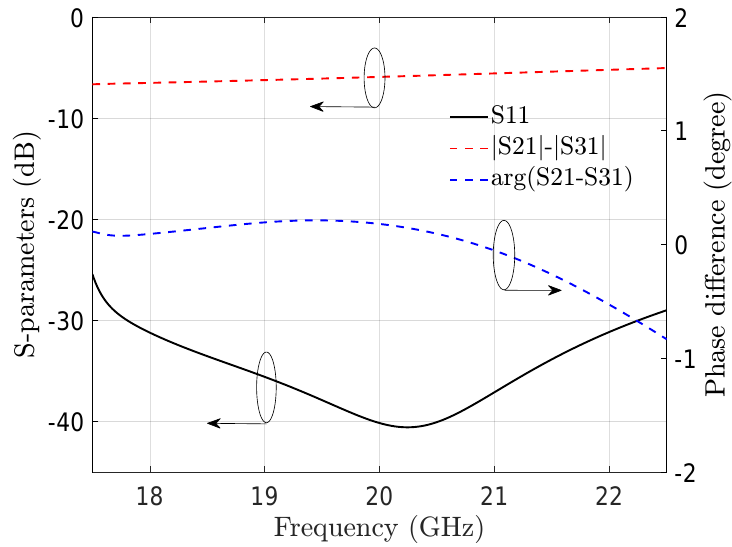
Figure 7. Simulated phase balance and S-parameters of the 6 dB power